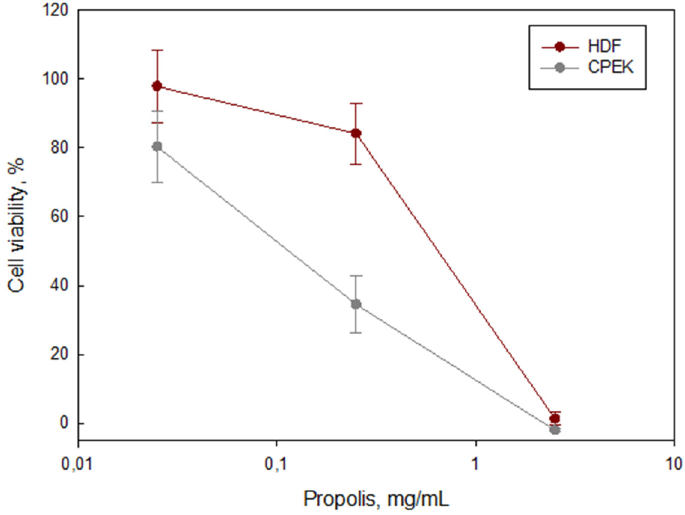
Figure 2. Effect of propolis (PEE) on the cell viability of fibroblasts (HDF) and keratinocytes (CPEK). Control was obtained from untreated cells (viability = 100%); Triton 1% was used as positive control for the loss of cell viability (viability = 0%).